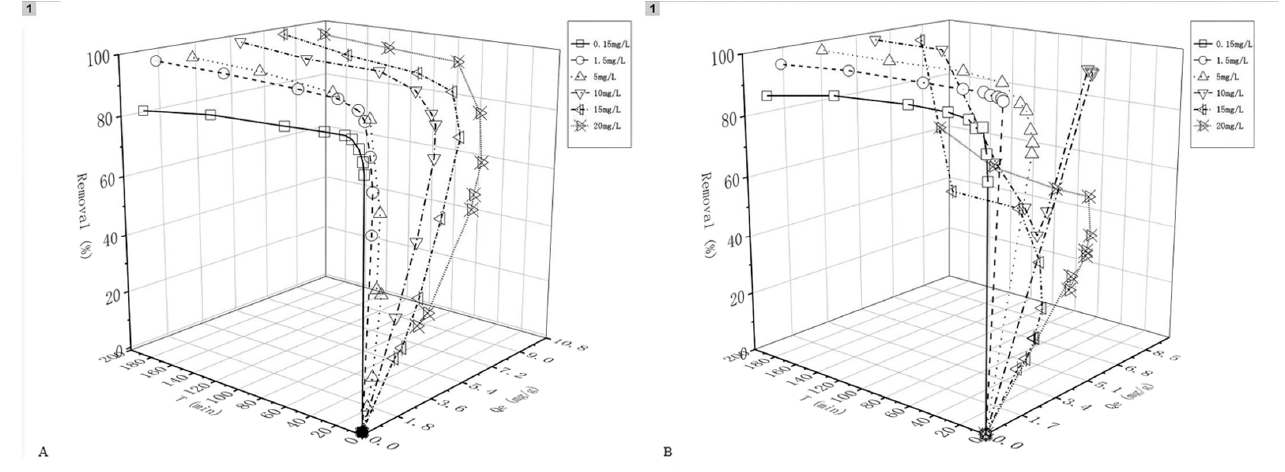
Figure 6. Qe and removal of different concentrations with time (( A ): NaAsO 2 , ( B ): H 3 AsO 4 ). Parameters of the pseudo-first- and second-order models are all shown in Table 4 and Figure 7. The dynamic sorption process of arsenic removal was adapted to three stages: